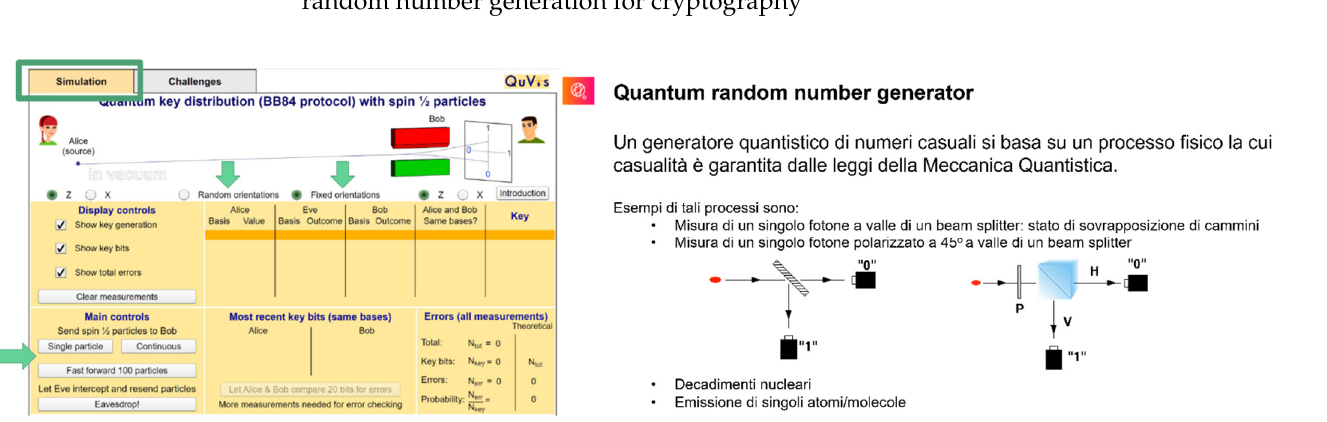
Figure A3. Examples from the specific path “Fundamentals: Polarization”. Screenshots of the slides used during the lectures. Top left : summary of the lectures. Top right : examples of polaroid superposition. Bottom : schematics of the behavior of polarized photons passing through polaroid filters. 